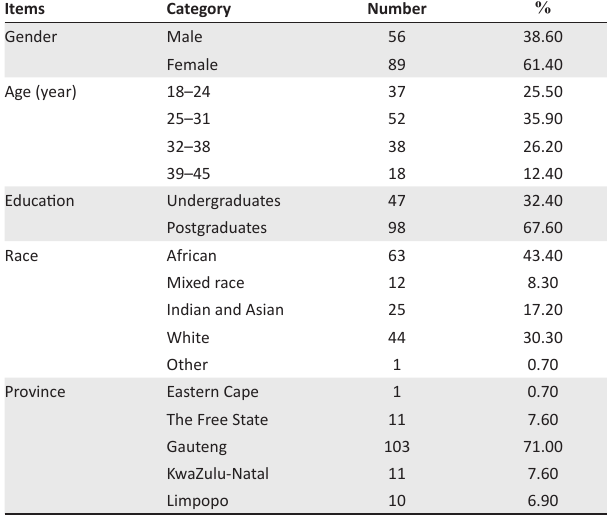
TABLE 1: Demographic profiles of the quantitative and qualitative samples: